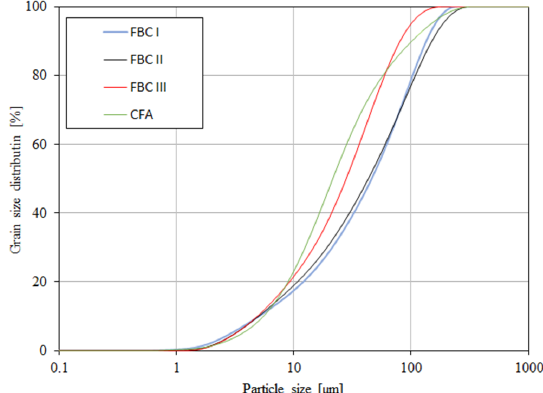
Figure 6. Accumulation curve of particle size distribution for FBC fly ash (FBC I, FBC II, FBC III) and fly ash from pulverized coal-fired boilers (CFA).